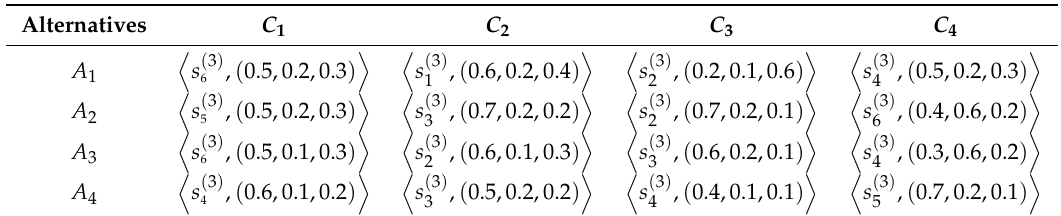
Table 3. SVNL decision matrix D 3 .